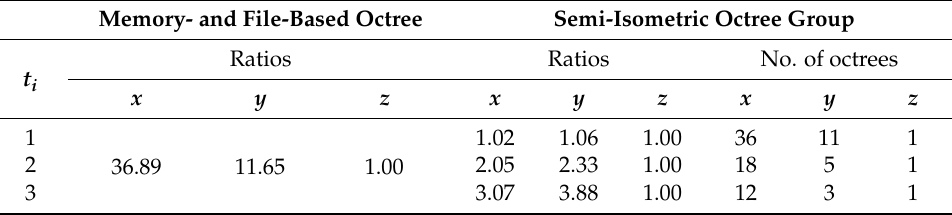
Table 5. Comparison of leaf node dimensions of Data